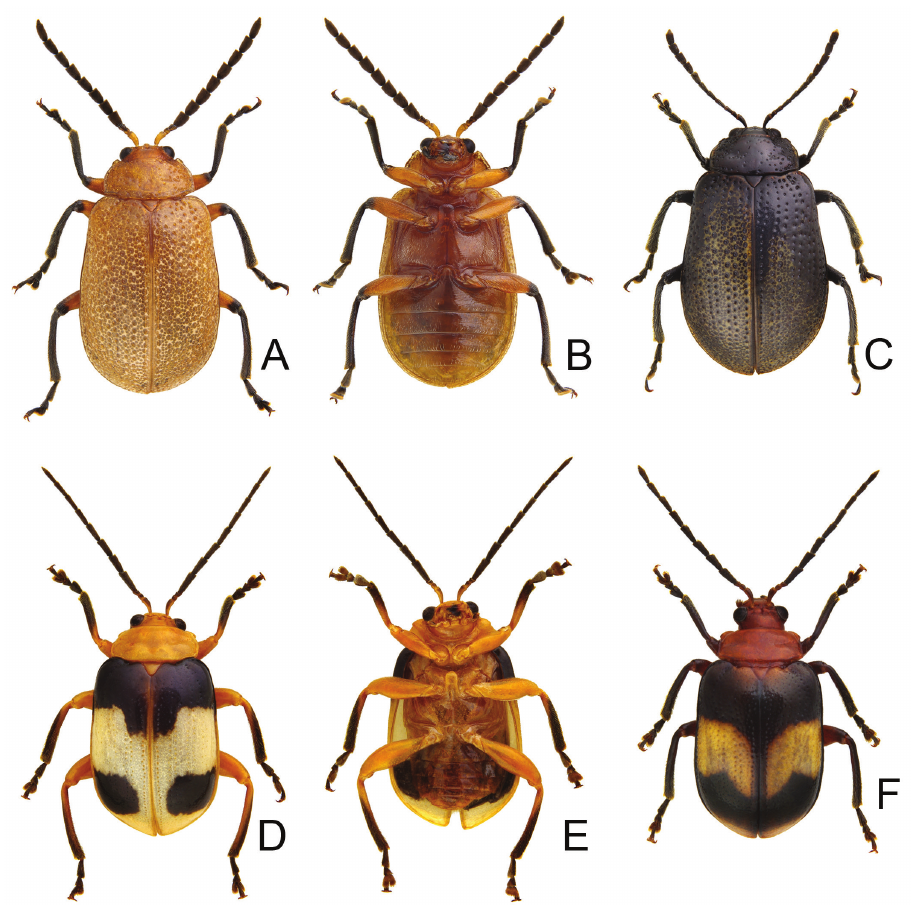
Figures 6. Habitus of Gallerucida species. A G. lutea Gressitt & Kimoto, male, dorsal view B Ditto, ventral view C G. lutea Gressitt & Kimoto, female, color variation, dorsal view D G. sauteri Chûjô, male, dorsal view E Ditto, ventral view F G. sauteri Chûjô, male, color variation, dorsal view. Diagnosis. Gallerucida lutea adults can be recognized by their yellowish brown bodies. Darker individuals of G. lutea may look like entirely black individuals of G. bifasciata , but the elytra of G. lutea possess extremely coarse punctures and minute punctures between coarse punctures and filiform antenna. Redescription. Length 8.4–9.8 mm, width 4.7–5.9 mm. General color (Fig. 6A– B) yellowish or reddish brown; antenna black except three basal antennomeres; tibiae and tarsi entirely black. Antenna serrate in male (Fig. 7A), length ratios of antenno- meres I–XI 1.0 : 0.4 : 0.6 : 0.9 : 0.8 : 0.9 : 0.9 : 0.9 : 0.9 : 0.9 : 1.2, length to width ratios of antennomeres I–IX 2.5 : 1.4 : 1.5 : 1.8 : 1.8 : 1.9 : 2.0 : 2.0 : 2.5 : 2.6 : 4.0; antennomeres IV-VII filiform and VIII-X serrate in female (Fig. 7B), length ratios of antennomeres I–XI 1.0 : 0.4 : 0.5 : 0.7 : 0.6 : 0.7 : 0.7 : 0.6 : 0.6 : 0.6 : 0.8, length